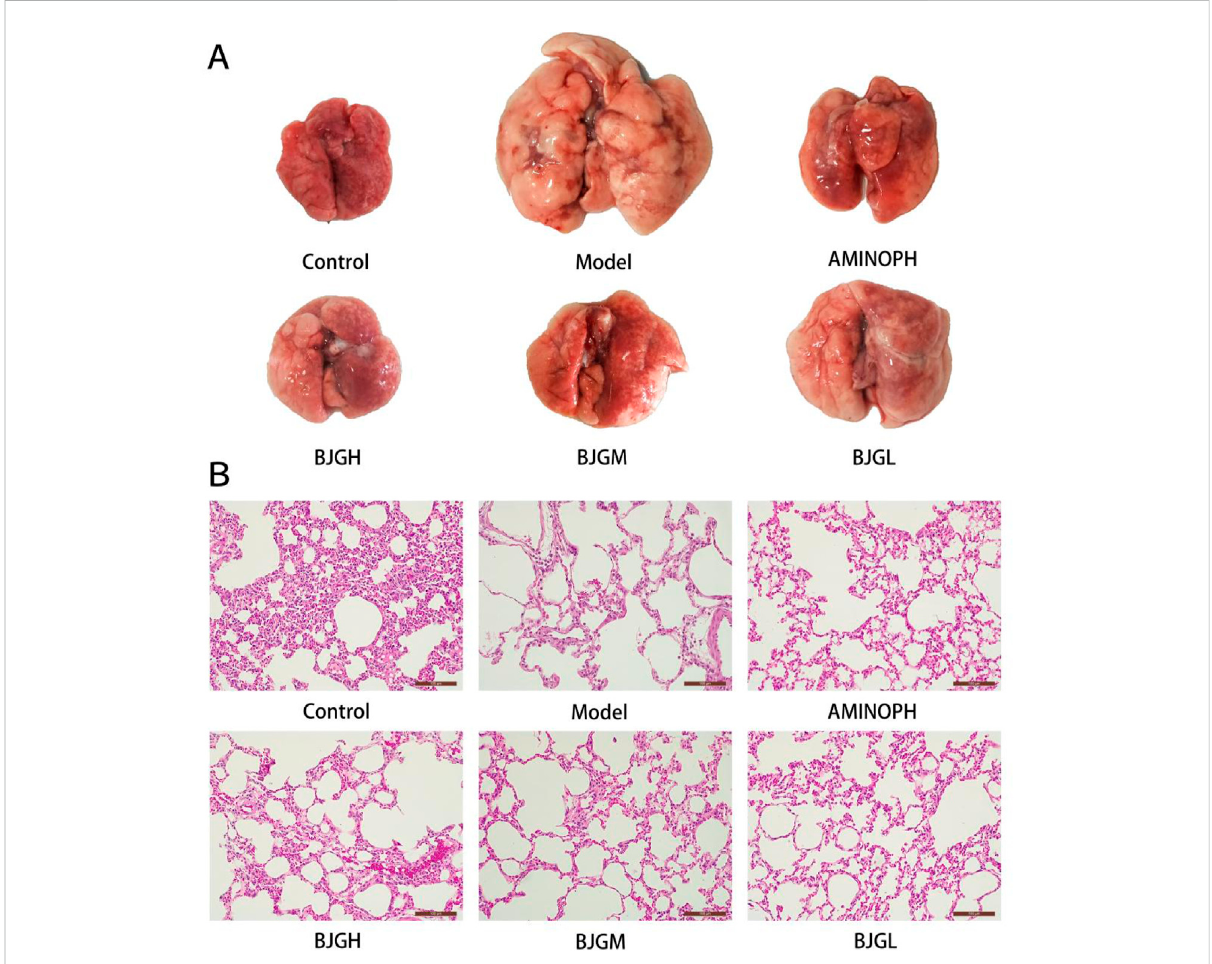
FIGURE 3 (A) Morphological changes in the lung tissue of rats. (B) Pathological changes in the lung tissue of rats [HE staining (magni fi cation